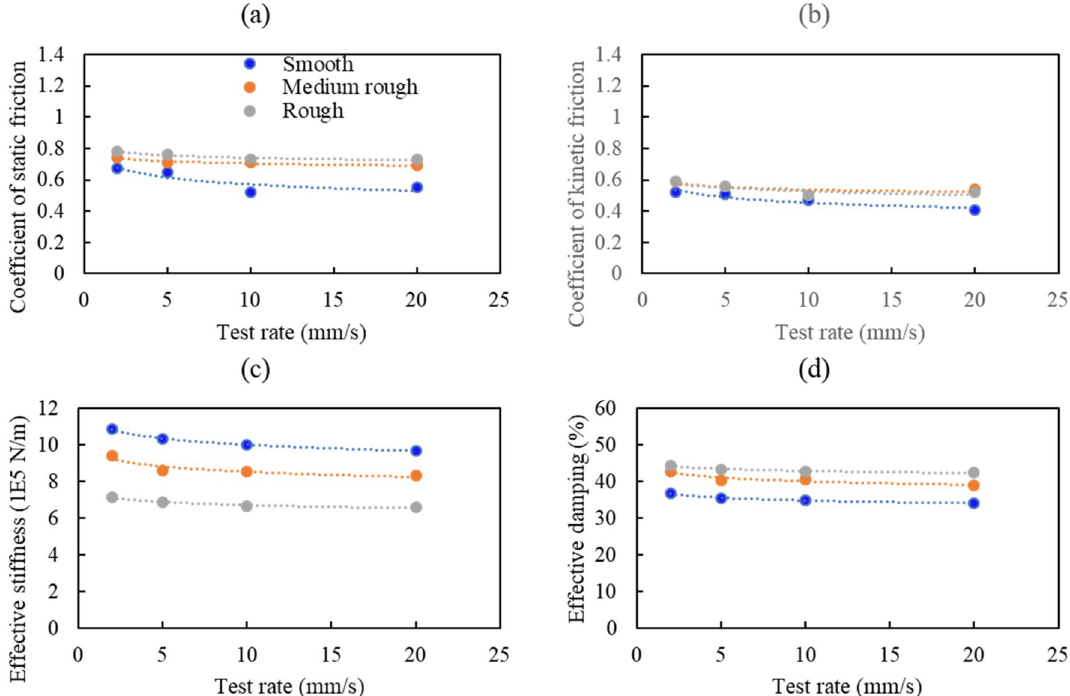
Figure 17. Variation of selected response quantities with the test rate at 0.25 MPa additional normal